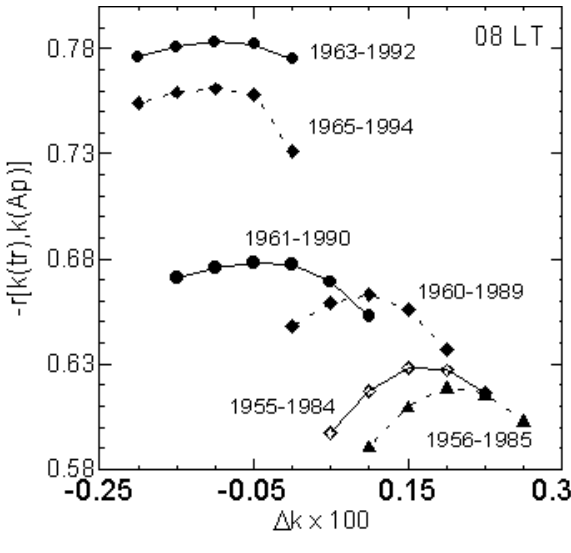
Fig. 3. Determination of the 1k value at the negative relation be- tween δ f o F2 and A p .